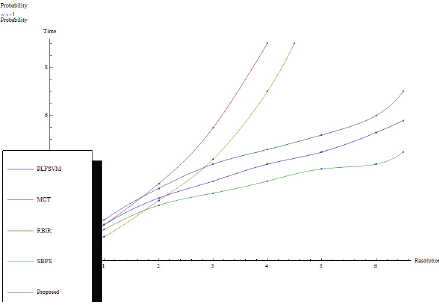
Figure 9: Performance of the proposed approach and other competitive techniques.